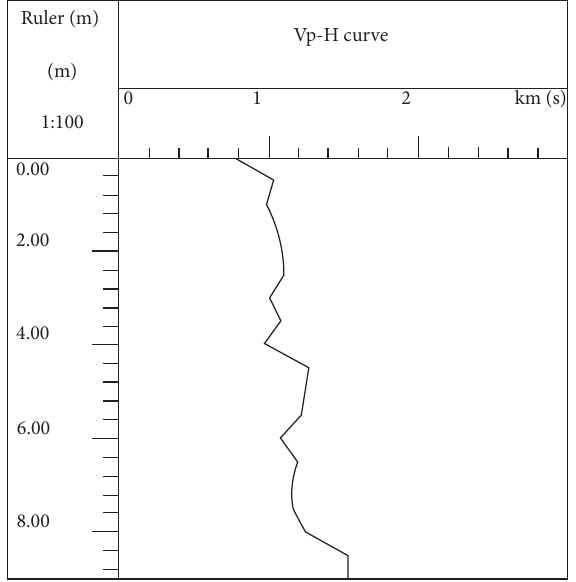
Figure 8: Variation pattern of wave velocity error with depth of measuring